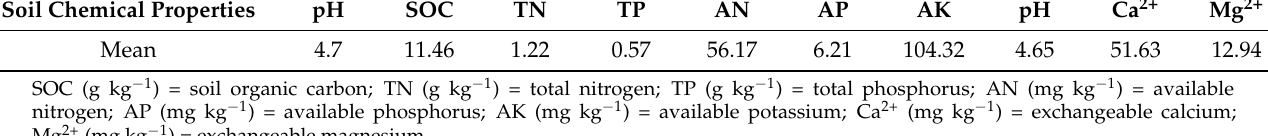
Table 1. Soil chemical properties before the planting of D. odorifera and Eucalyptus . Soil Chemical